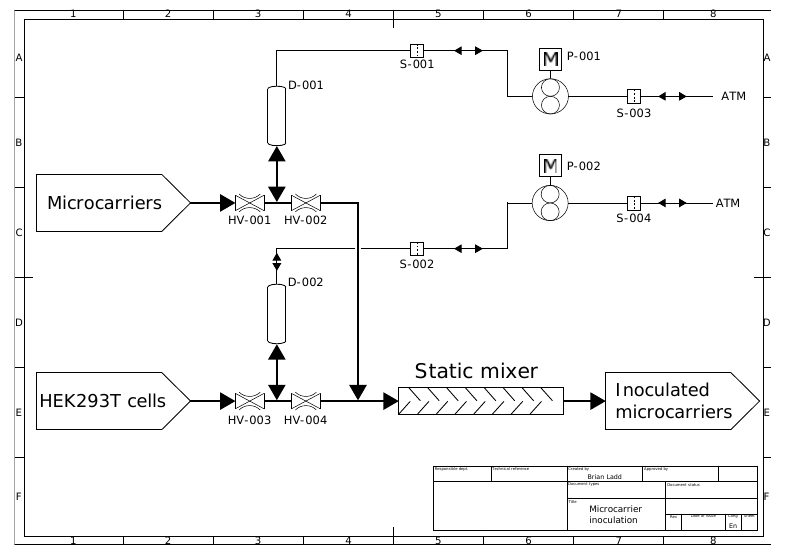
Figure 10. Process flow diagram of the continuous microcarrier inoculation system; D-001 and D-002 are 10 mL vessels; HV-001 to HV-004 are pinch valves; P-001 and P-002 are air pumps; S-001 to S-004 are 0.2 µm sterile air filters; ATM denotes atmosphere; DASBox bioreactor vessels are connected to labels “Microcarriers“, “HEK293T cells“ and “Inoculated microcarriers“.